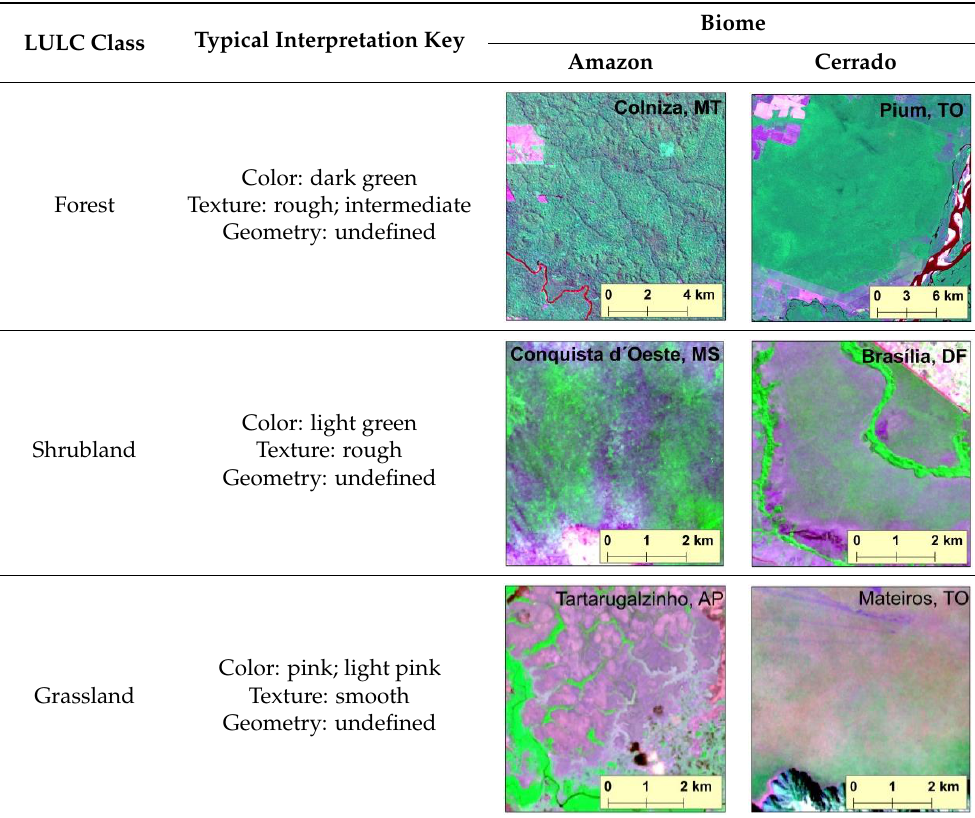
Figure 4. Landsat 8 OLI image sampling points per state predicted by the sampling design (confluence of 0.5 × 0.5 degree regular grid) and corresponding number of cloud-free Land- sat 8 OLI images in the Amazon ( A ) and Cerrado ( B ) biomes. Red circles are the sampling sites without cloud-free images. Total number of cloud-free image sampling points: 929 for the Amazon biome and 690 for the Cerrado biome. Table 1. Interpretation key for the Landsat 8 OLI, RGB color composites of bands 4, 5, and 6 for forest and other representative and most extensive land use and land cover (LULC) classes found in the Amazon and Cerrado biomes (shrublands, grasslands, croplands, and cultivated pas- turelands).